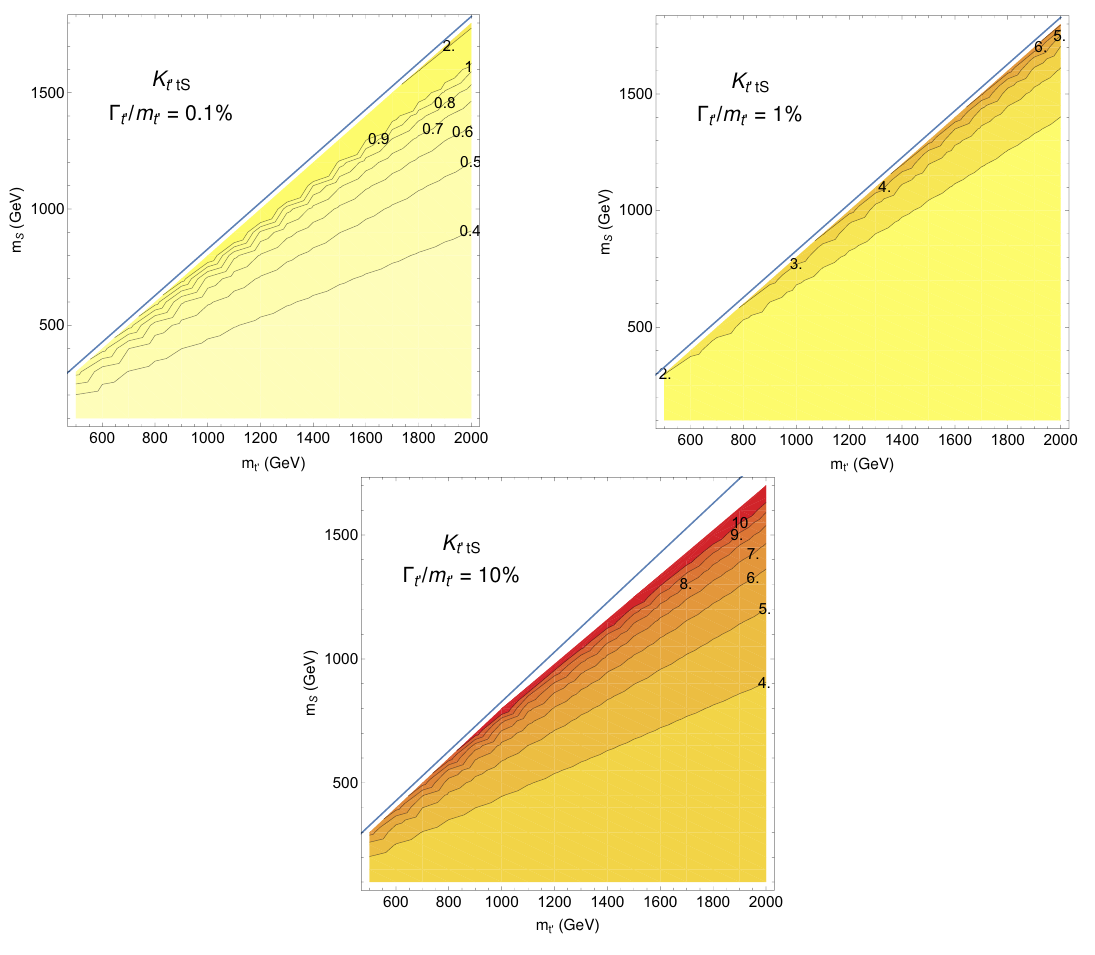
Figure 15 . Values of the (cid:20) S coupling corresponding to (cid:12)xed (cid:0) t 0 =m t 0 ratios (0.1%, 1% and 10%) L;R in the f m t 0 ; m S g plane. The blue contour corresponds to the kinematic limit m t 0 (cid:0) m t (cid:0) m S = 0. The maximum value for the coupling to be in the perturbative region has been limited to 4 (cid:25)